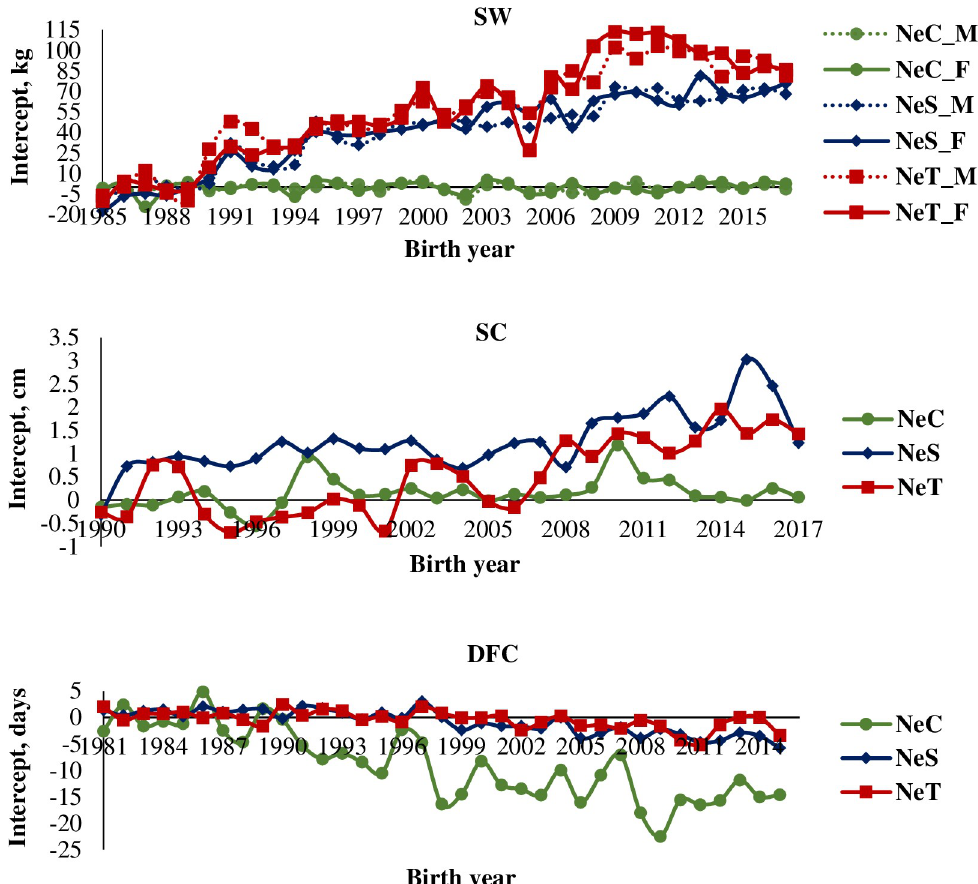
Fig 3. Genetic trends for regression coefficients related to the intercept of reaction norms for Selection Weight (SW), Scrotal Circumference (SC), and Days at First Calving (DFC) in three Nellore cattle lines (NeC, control; NeS, selection; and NeT, traditional). NeC_M, males of the control line; NeC_F, females of the control line; NeS_M, males of the selection line; NeS_F, females of the selection line; NeT_M, males of the traditional line; NeT_F, females of the traditional